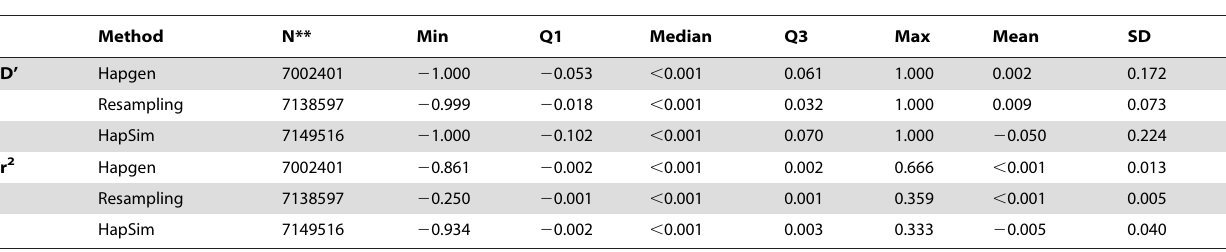
Table 5. LD–Gene Region 2*.